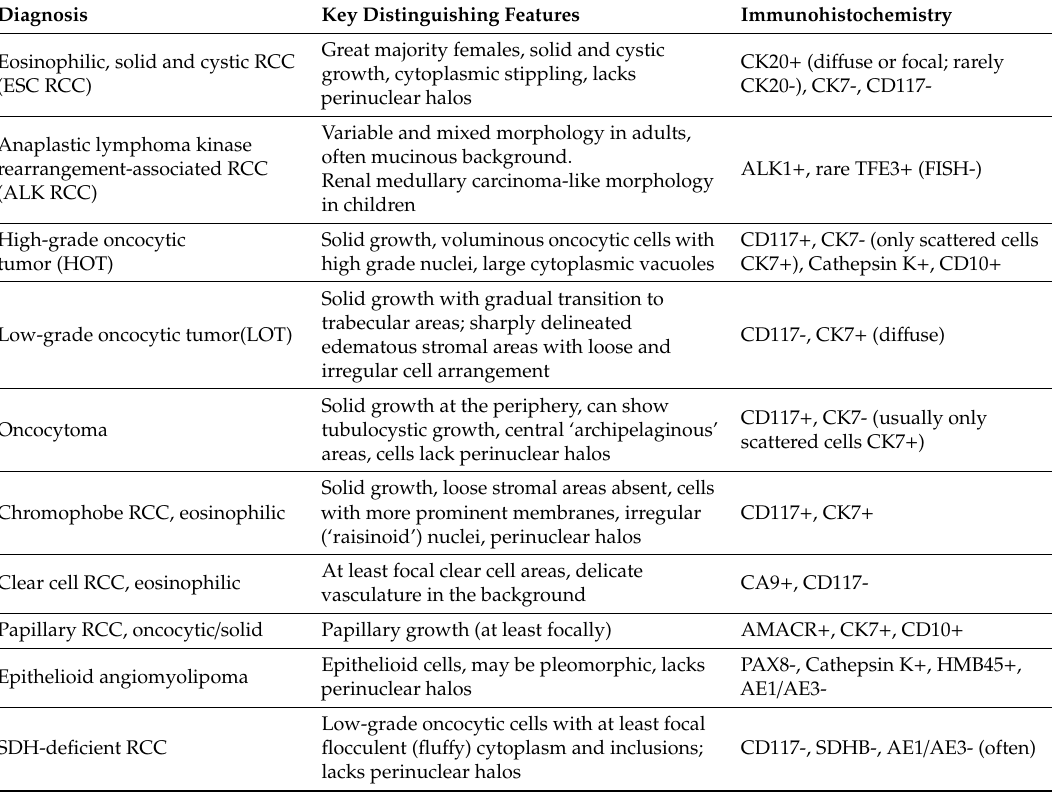
Table 2. Key distinguishing features of the emerging renal tumors vs. other eosinophilic / oncocytic renal